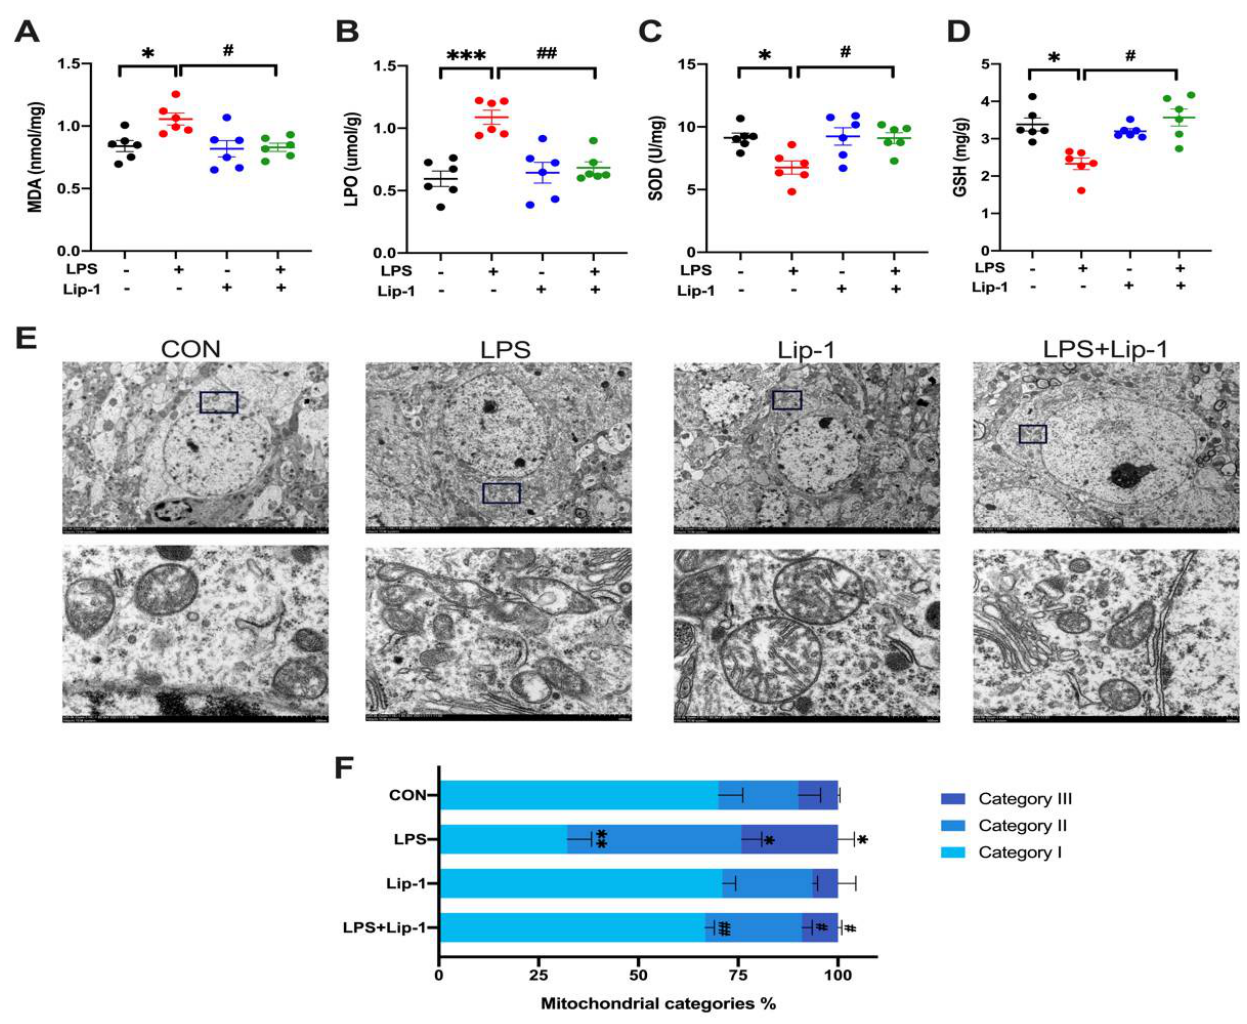
Figure 5. Liproxstatin-1 ameliorated oxidative stress, lipid peroxidation and hippocampus neuronal mitochondria injury caused by LPS. ( A ) MDA levels, ( B ) LPO levels, ( C ) SOD activities and ( D ) GSH contents in hippocampus ( n = 6). ( E ) Transmission electron microscopy images of hippocampus neuronal mitochondria from each group (scale bar = 5 µ m for above and 500 nm for below). ( F ) The percentage of different types of hippocampus neuronal mitochondria: category I (containing a network of elongated mitochondria), category II (containing fragmented but evenly distributed mitochondria), category III (containing mainly fragmented mitochondria) ( n = 3). Data are expressed as mean ± SE. * p < 0.05, ** p < 0.01, *** p < 0.001 vs. CON group; # p < 0.05, ## p < 0.01 vs. LPS group. Iron accumulation can cause tissue damage, and disturbances in iron metabolism are essential for lipid peroxide accumulation and initiation of the ferroptosis pathway [31]. Our data showed a significant increase in iron content in the LPS group ( p < 0.001; Figure 6A), which was ameliorated by liproxstatin-1 ( p < 0.01; Figure 6A). The expression levels of ferroptosis-related proteins (TF, xCT, FtMt, Gpx4, Fth) were determined by western blot. The levels of xCT, FtMt Gpx4, and Fth were lower in the LPS group than in the CON group, but in the LPS + Lip-1 group, liproxstatin-1 attenuated this change ( p < 0.05 for xCT, FtMt, Gpx4, Fth; Figure 6C–F). The level of TF was higher in the LPS group than in the CON group ( p < 0.05; Figure 6B) but it was lower in the LPS + Lip-1 group than in the LPS group ( p < 0.05; Figure